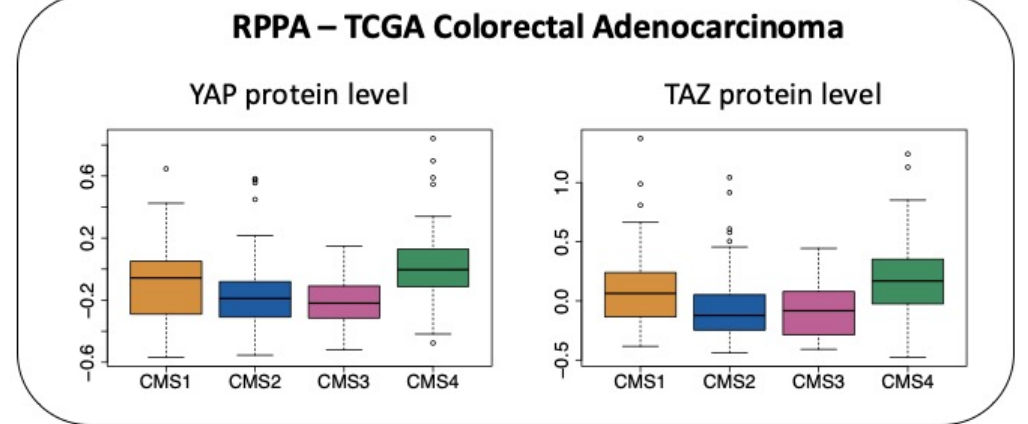
Figure 3. Expression of YAP and TAZ in CRC patients according to the CMS classification. Top panel: expression of YAP1 mRNA and WWTR1 (encoding TAZ) mRNA as well as the determination of the YAP / TAZ target score as defined in [26] in the 566 CRC patients of the GSE39582 dataset [18] according to the CMS classification [2]. p < 0.05 for CMS4 versus CMS1 and p < 0.0001 for CMS4 versus CMS3 or versus NT respectively for YAP1 (Tukey post hoc test). p < 0.0001 for CMS4 vs. other CMS or vs. NT for WWTR1 and YAP / TAZ target score. NT indicates non-tumour samples. Kaplan–Meier overall survival according to high and low YAP / TAZ target score was determined in the GSE39582 dataset. Bottom panel: protein levels of YAP and TAZ determined through Reverse Phase Protein Array (RPPA) in The Cancer Proteome Atlas of colorectal adenocarcinoma [27], according to the CMS classification [2]. p < 0.05 for CMS4 vs. CMS1 and p < 0.0001 for CMS4 vs. CMS2 or vs. CMS3 for YAP. p < 0.0001 for CMS4 vs. CMS2 or vs. CMS3 for TAZ (Tukey post hoc test).